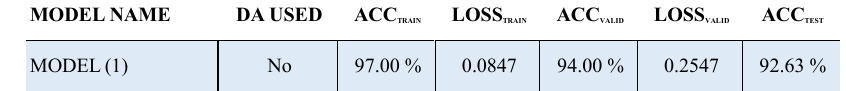
Table 3. A holistic comparison of different CNN models for the classification of different types of tumors. These algorithms are compared on basis if data augmentation had been used or not, training accuracy (ACC TRAIN ), training loss (LOSS TRAIN ), validation accuracy (ACC VALID ), validation loss (LOSS VALID ), and test accuracy (ACC TEST